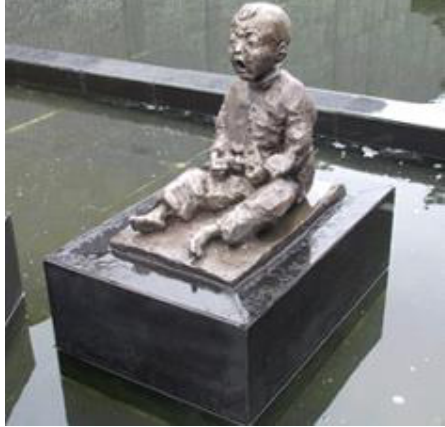
Figure 1. Baby Ping-Mei. Source: Karin